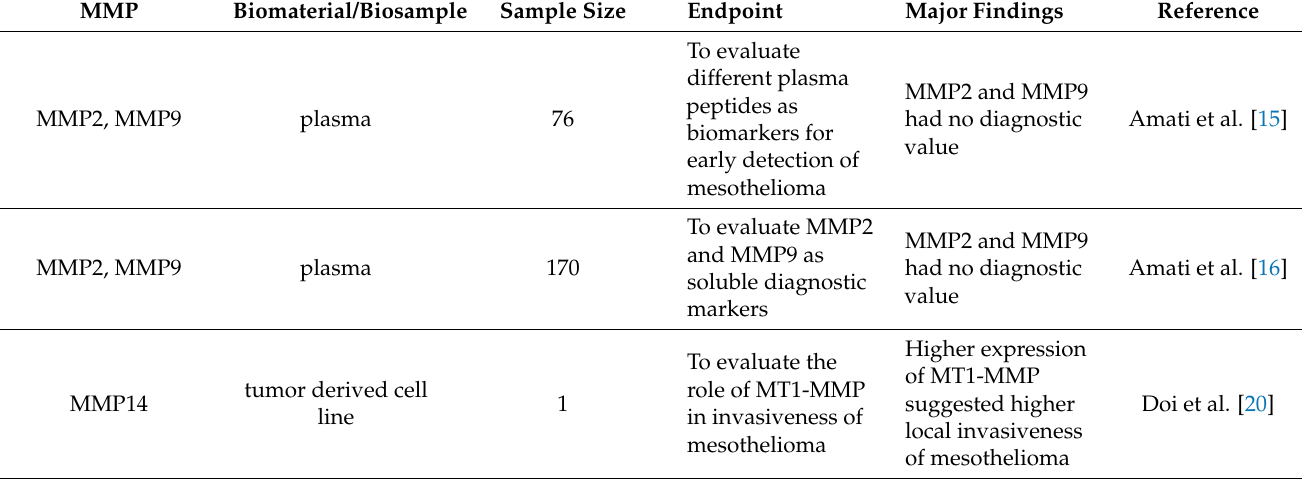
Table 1. Metalloproteinase (MMP) expression in mesothelioma tissues or body fluids.